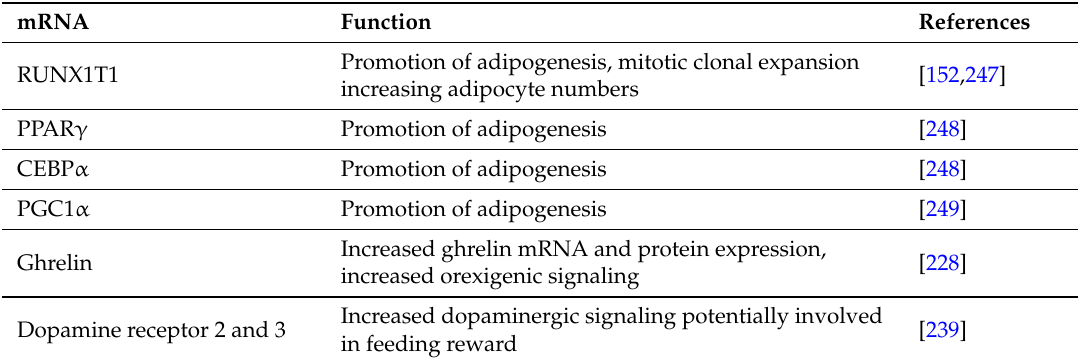
Table 3. Selected mRNAs upregulated via FTO-mediated m 6 A